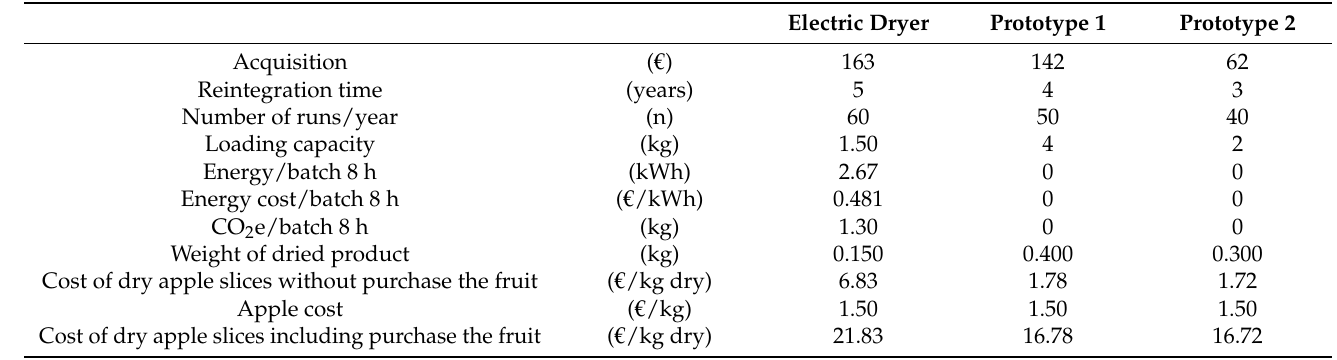
Table 1. Comparative costs of drying apple slices with commercial electrical dryer and solar proto-